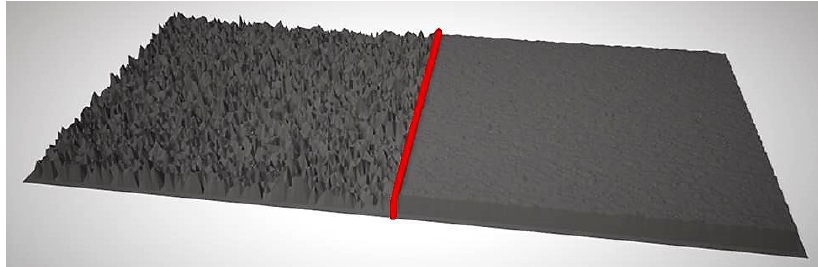
Figure 2. An example of a reconstructed 3D area, without ( left ) and with ( right ) application of a Gaussian filter: the applied filter reduces positive and negative peaks producing a more homogeneous and less noisy surface.